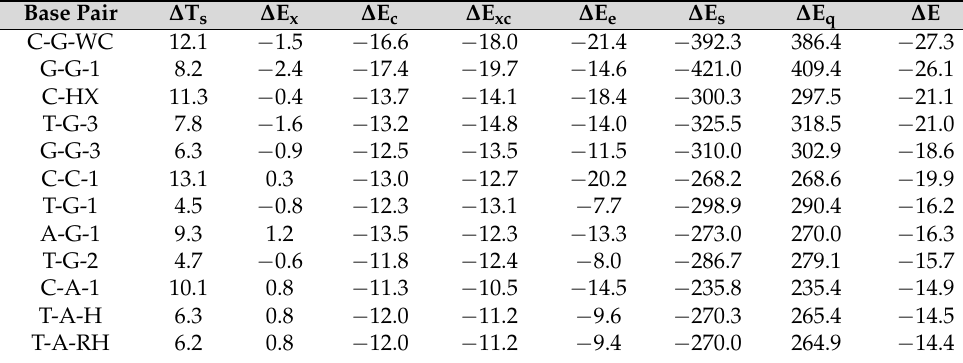
Table 2. Total energy difference ( ∆ E) and its components obtained at the M06-2X/Def2-TZVP level for 30 base pairs, including kinetic ( ∆ T s ), exchange-correlation ( ∆ E xc ), electrostatic potential ( ∆ E e ), steric hindrance ( ∆ E s ), and quantum effect ( ∆ E q ). Units are in kcal/mol. Base Pair ∆ T s ∆ E x ∆ E